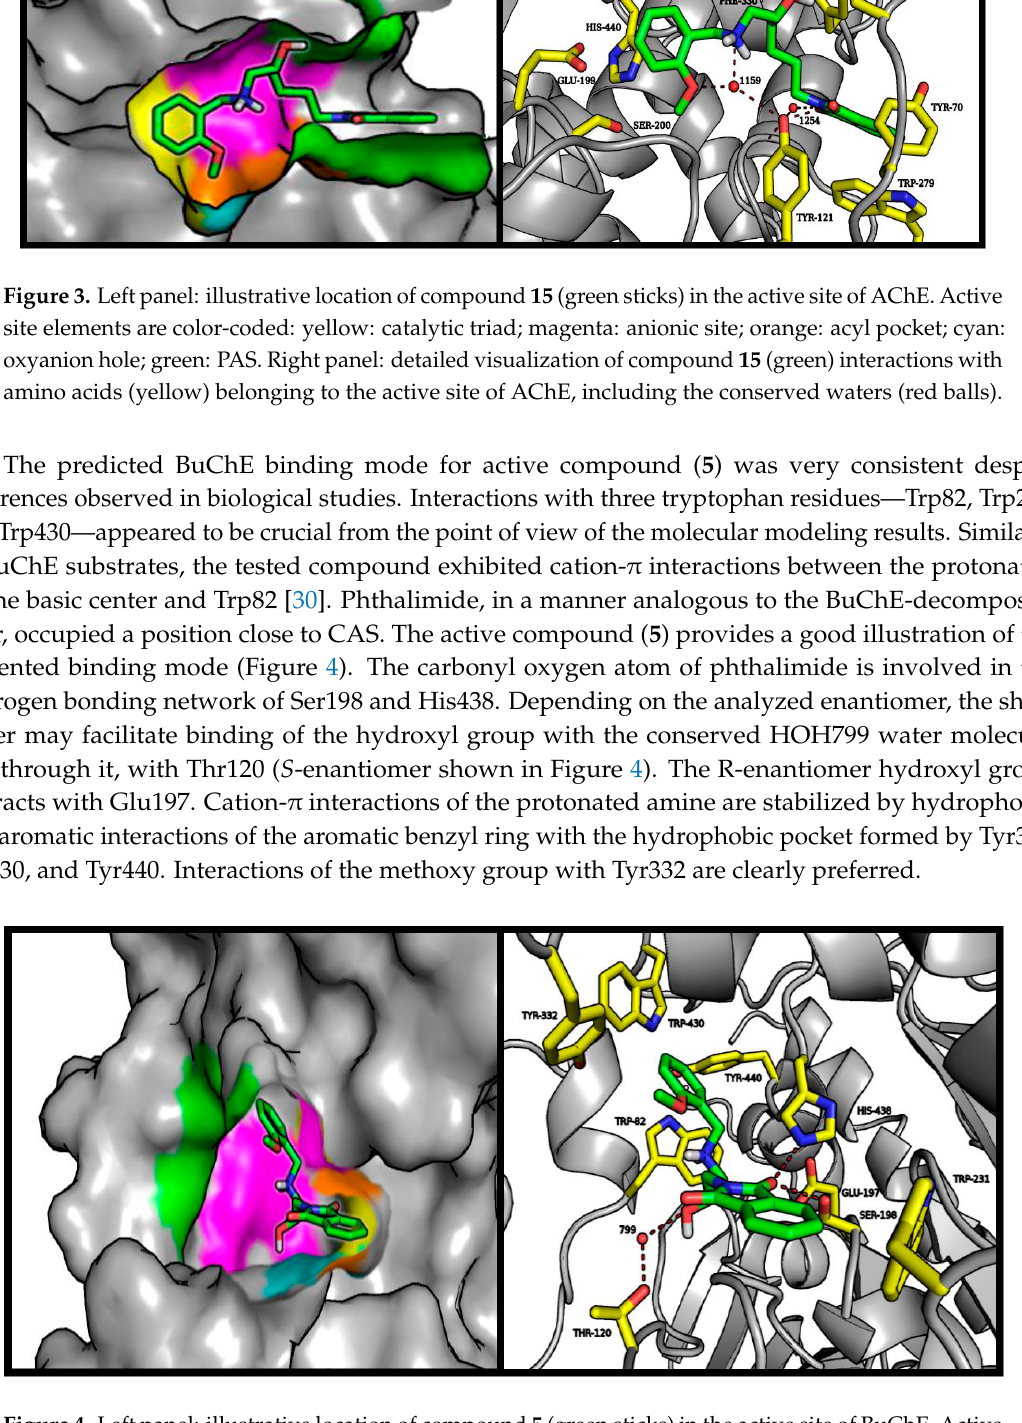
Figure 4. Left panel: illustrative location of compound 5 (green sticks) in the active site of BuChE. Active site elements are color-coded: yellow: catalytic triad; magenta: anionic site; orange: acyl pocket; cyan: oxyanion hole; green: PAS. Right panel: detailed visualization of compound 5 (green) interactions with amino acids (yellow) belonging to the active site of AChE, including the conserved water (red balls).